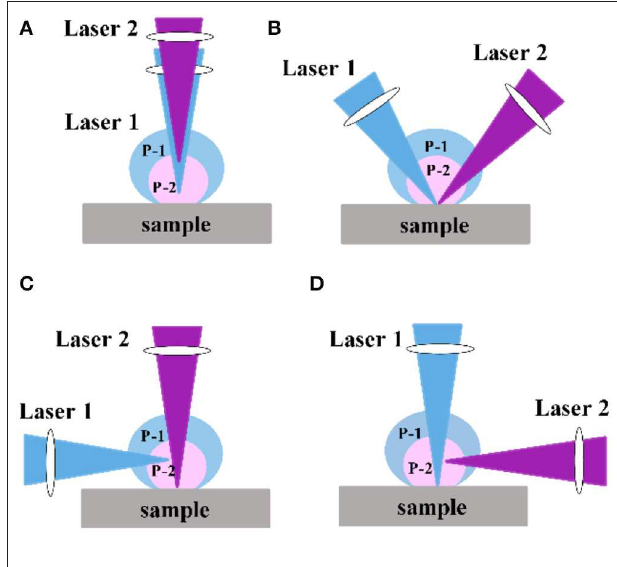
FIGURE 1 | Various configuration of DP-LIBS: (A) collinear; (B) dual pulse crossed beam; (C) orthogonal preheating; (D) orthogonal reheating; Labels (P-1) and (P-2) indicate the plasma produced by pulse1 and pulse 2, respectively.